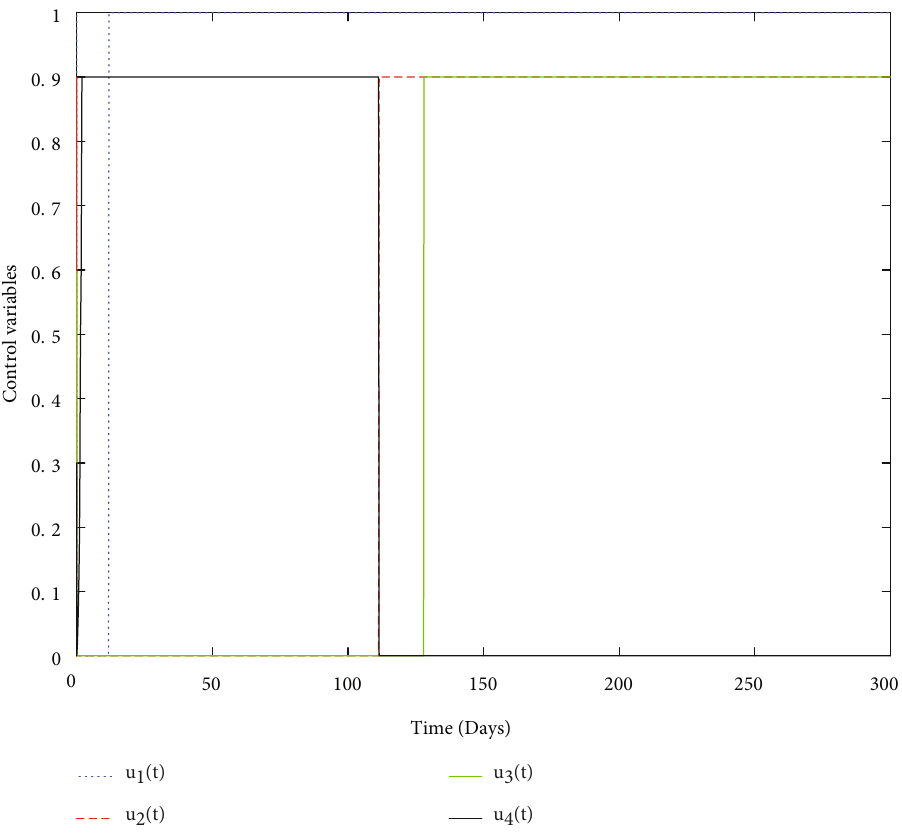
Figure 6: The dynamics of control